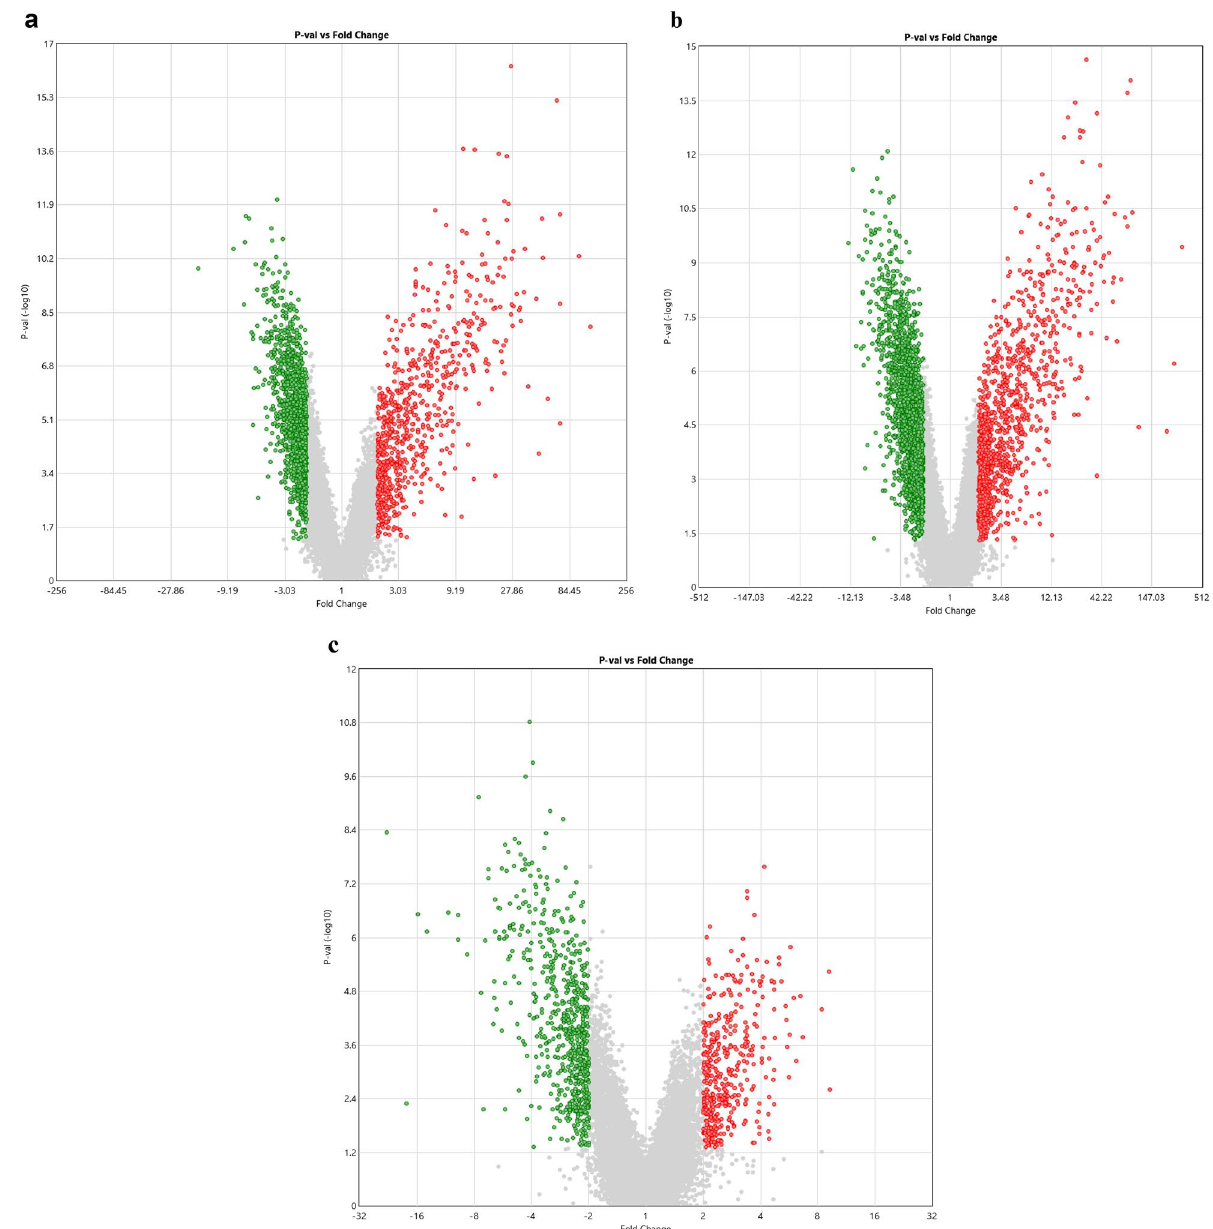
Figure 1. Volcano plots of the differentially regulated genes at a p-value of < 0.05 and a fold change of < − 2 or > 2. ( a ) 2073 differentially regulated genes in SCD patients in steady-state compared to healthy controls. ( b ) 3363 differentially regulated genes in SCD patients in VOC compared to healthy controls. ( c ) 1078 differentially regulated genes in SCD patients in VOC compared to SCD patients in